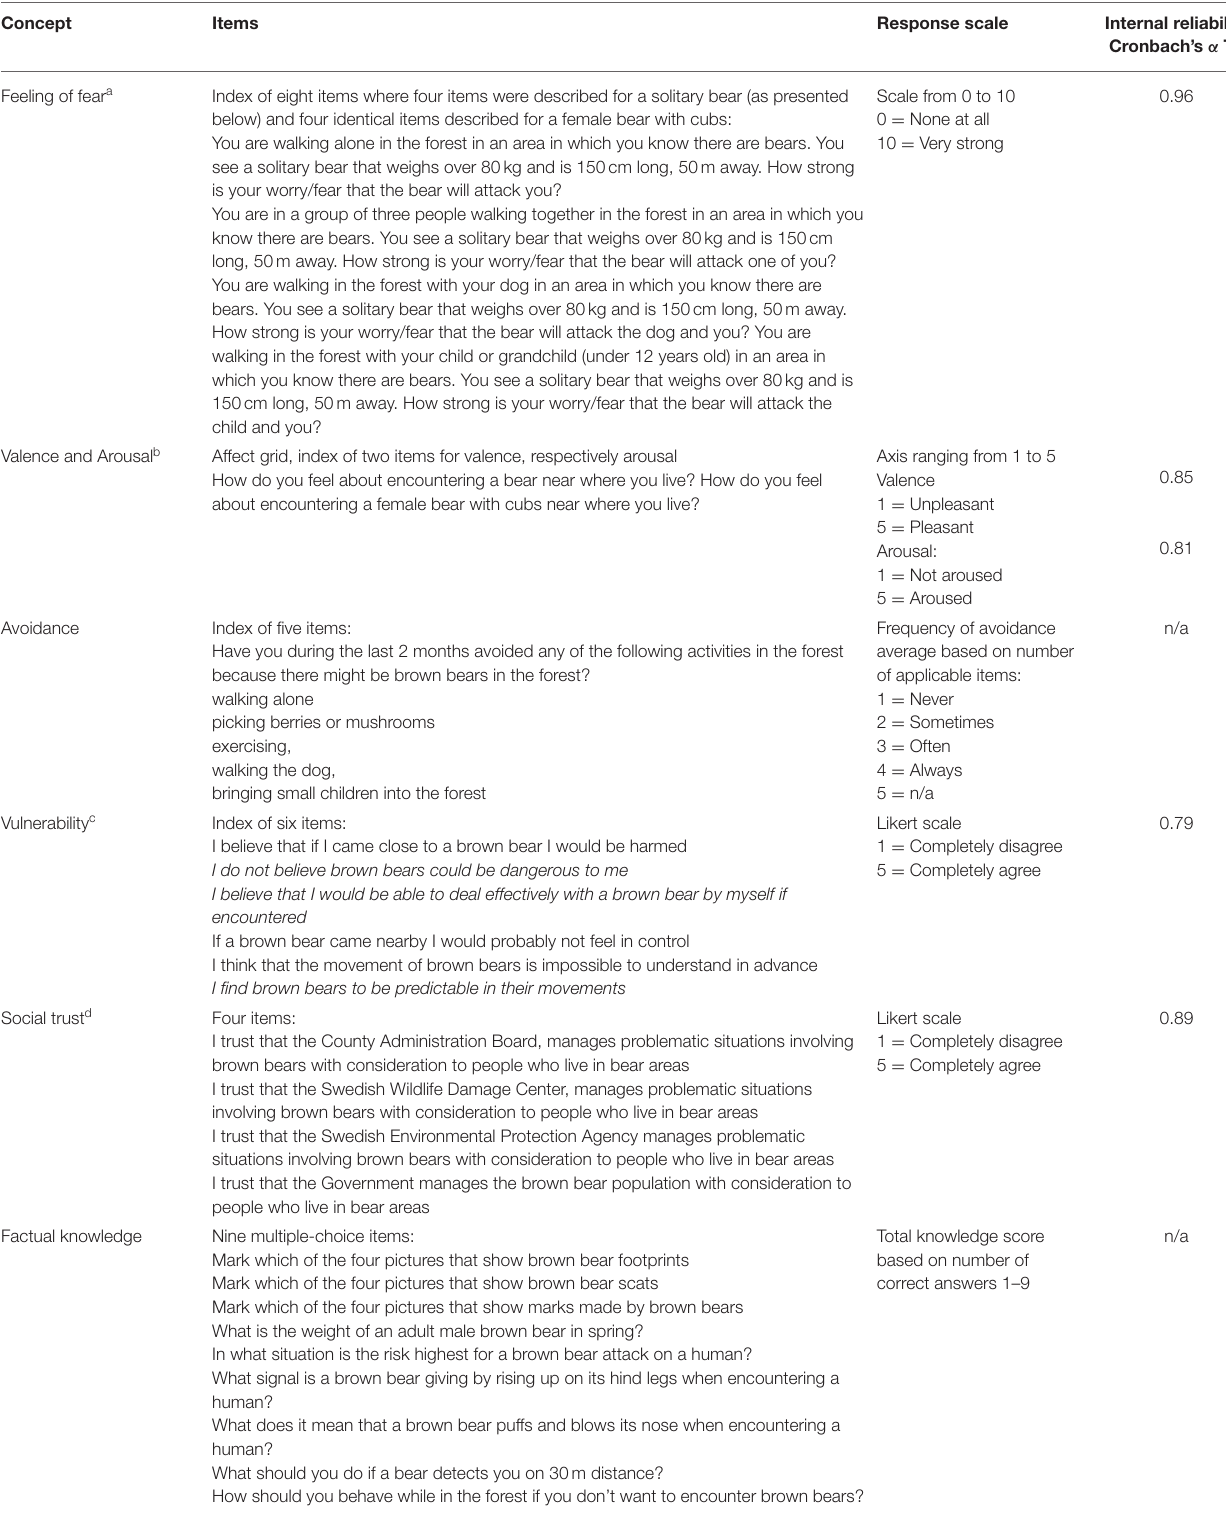
TABLE 1 | Overview of the concepts measured by means of the questionnaire including formulation of items, response scale and for calculated indices the internal reliability. Concept Items